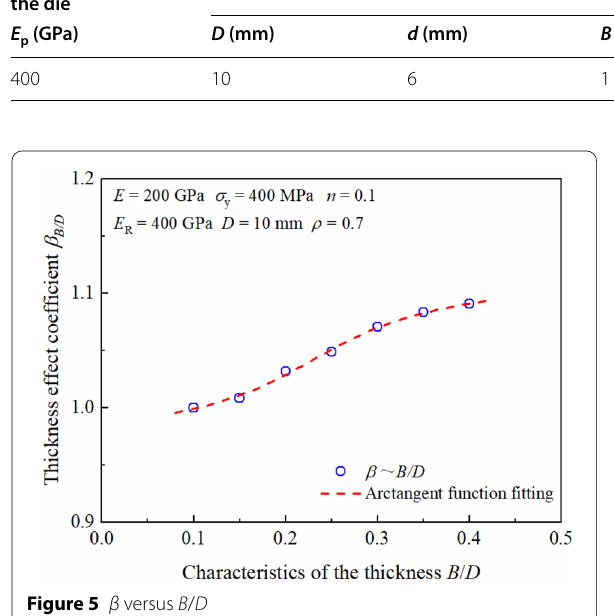
Table 1 FEA conditions for determine β Elastic modulus of the die